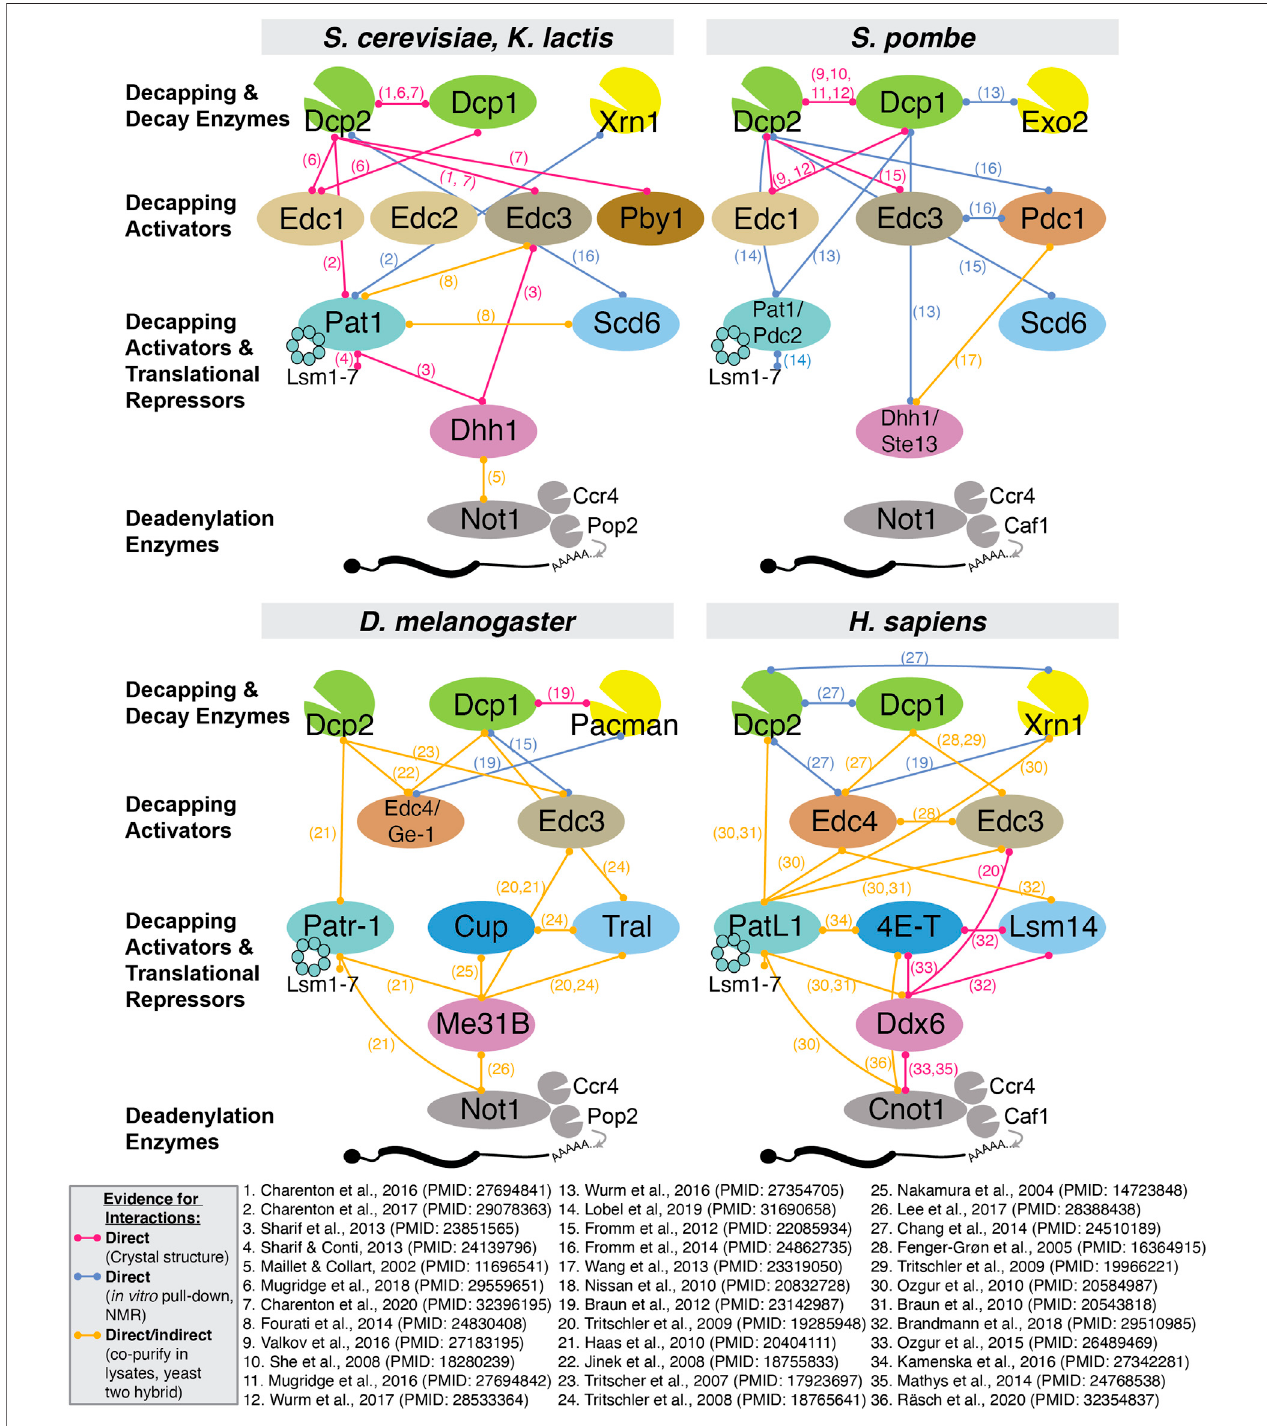
FIGURE 3 | Summary of all reported interactions between decapping proteins in S. cerevisiae , S. pombe , D. melanogaster and H. sapiens . Due to space constraints, we only include evidence from experimentally validated interactions and indicate whether evidence for direct physical interaction has been reported.